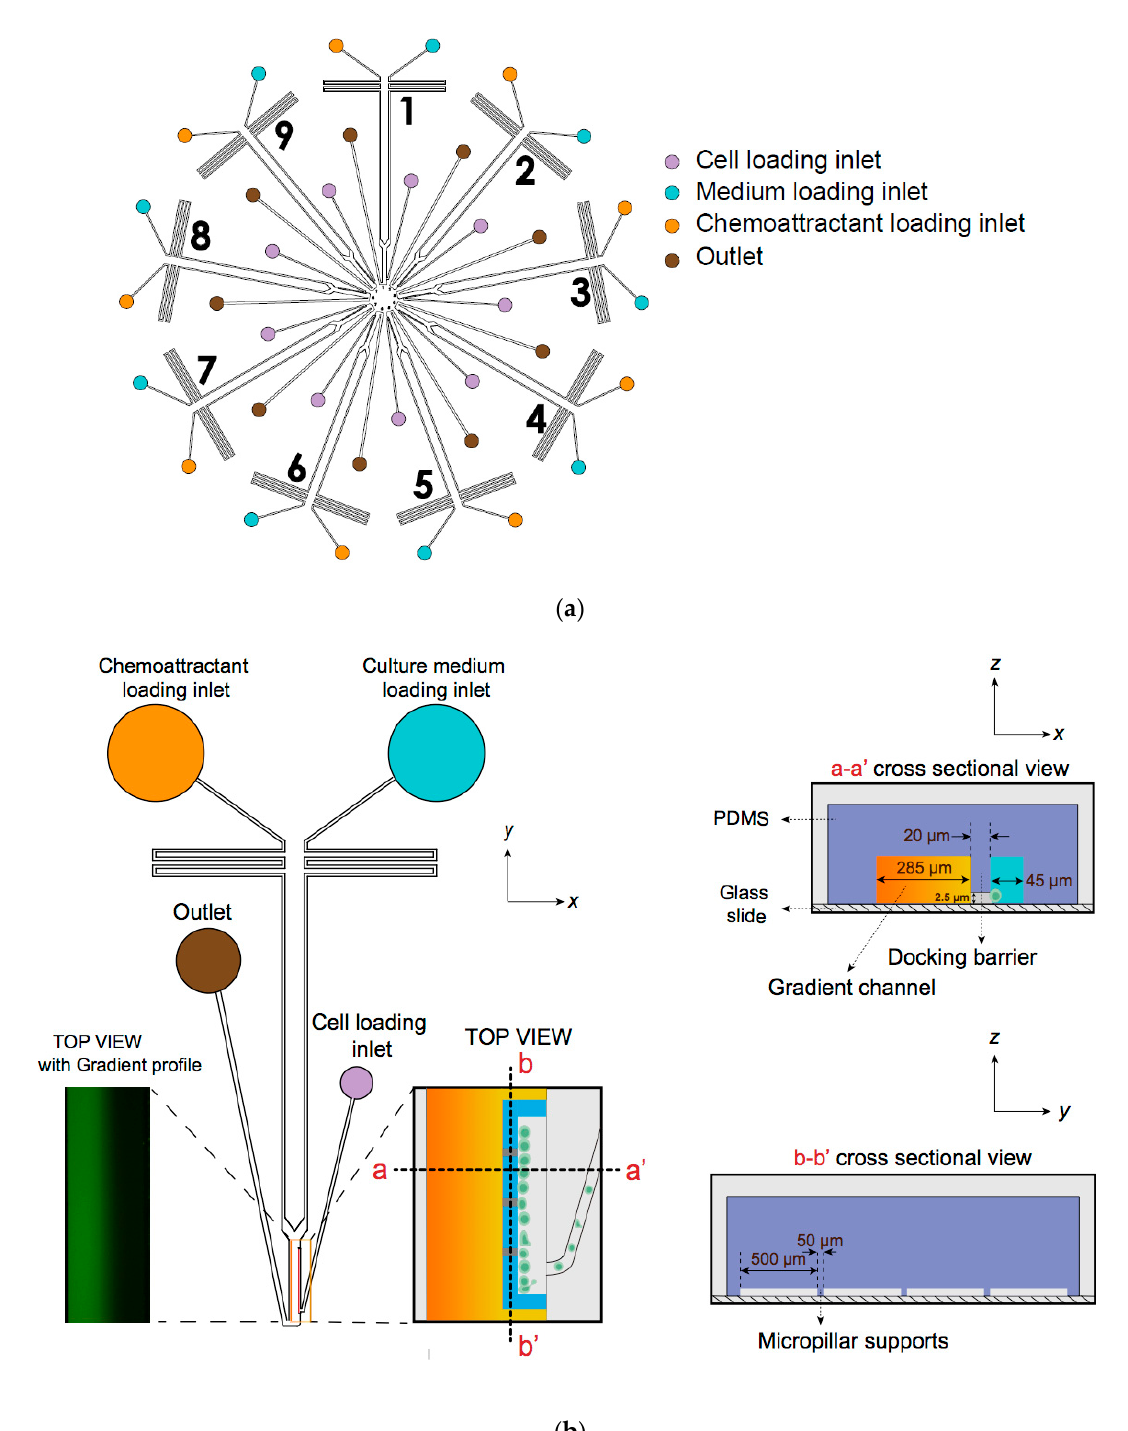
Figure 1. Illustration of the multi-channel radial microfluidic device. ( a ) Design of the nine-unit whole chip and illustration of the inlets and channels in the cells chemotaxis experiment. It provided independently controlled gradients by adding chemoattractant and medium to different loading inlets. ( b ) The cross-section view and top view of a single unit illustrated the cell docking structure and pillar support. The design of the cell docking structure aims to align cells and separate them from the cell loading channel and the main gradient